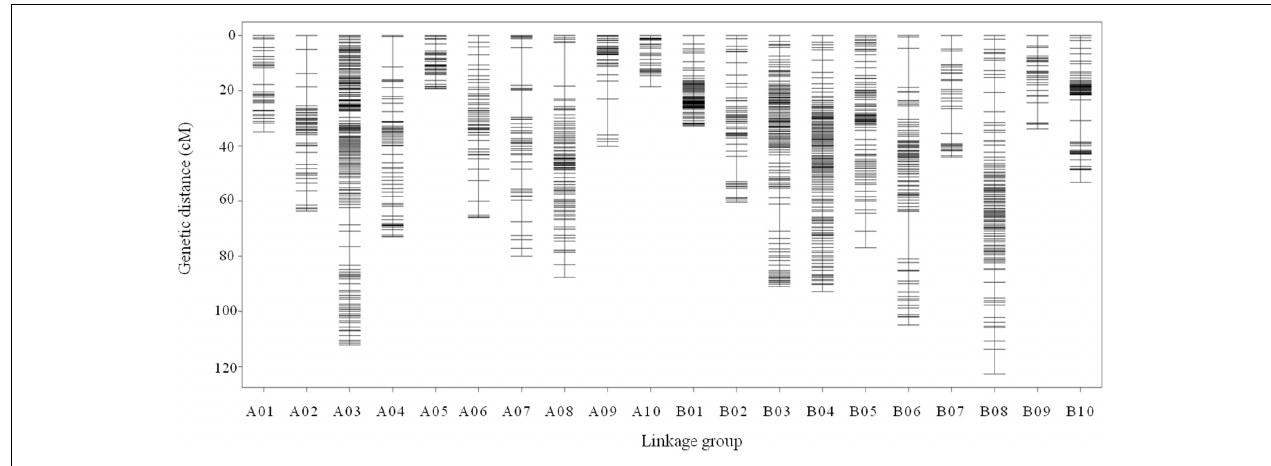
FIGURE 4 | High density genetic map with the 2,808 SNP markers distributed on 20 LGs of peanut. The x -axis represents the number of LGs and the y -axis represents the marker’s location in genetic map.